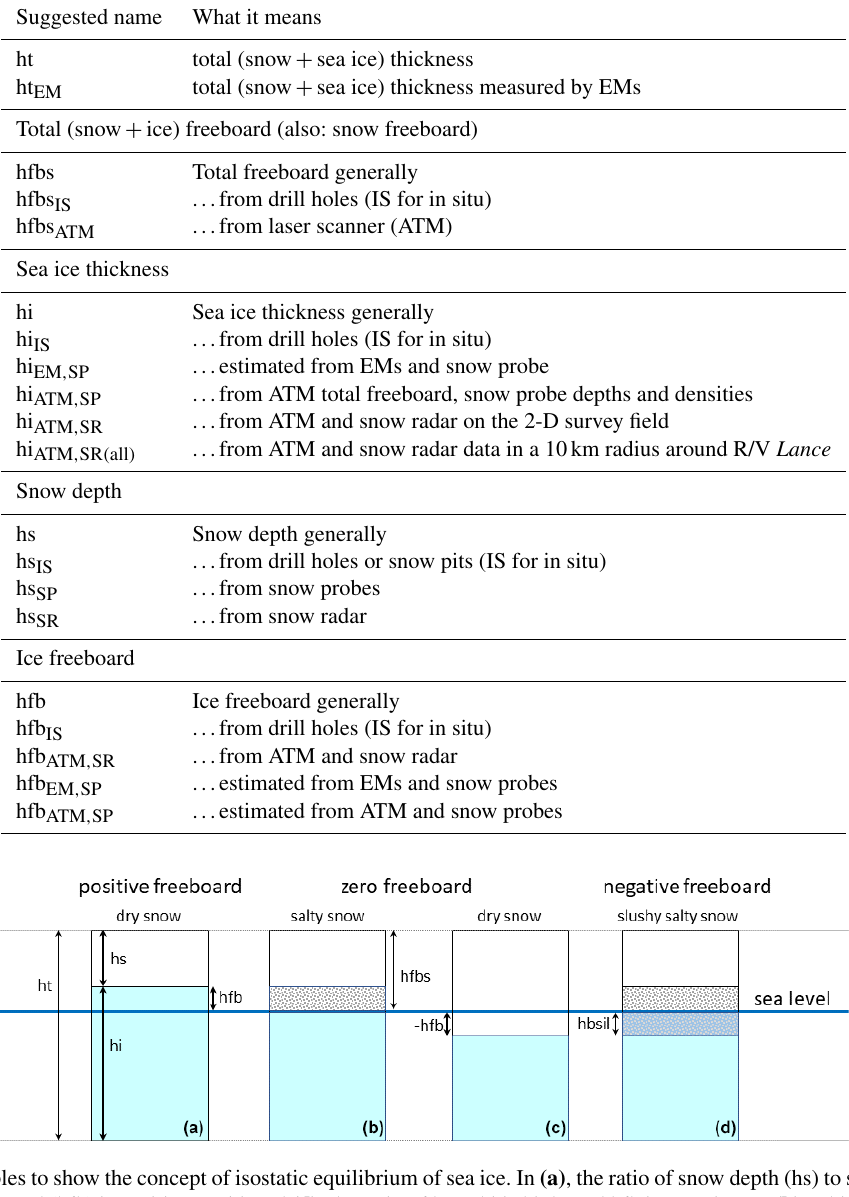
Table 1. A summary of all the variables used in the following context.